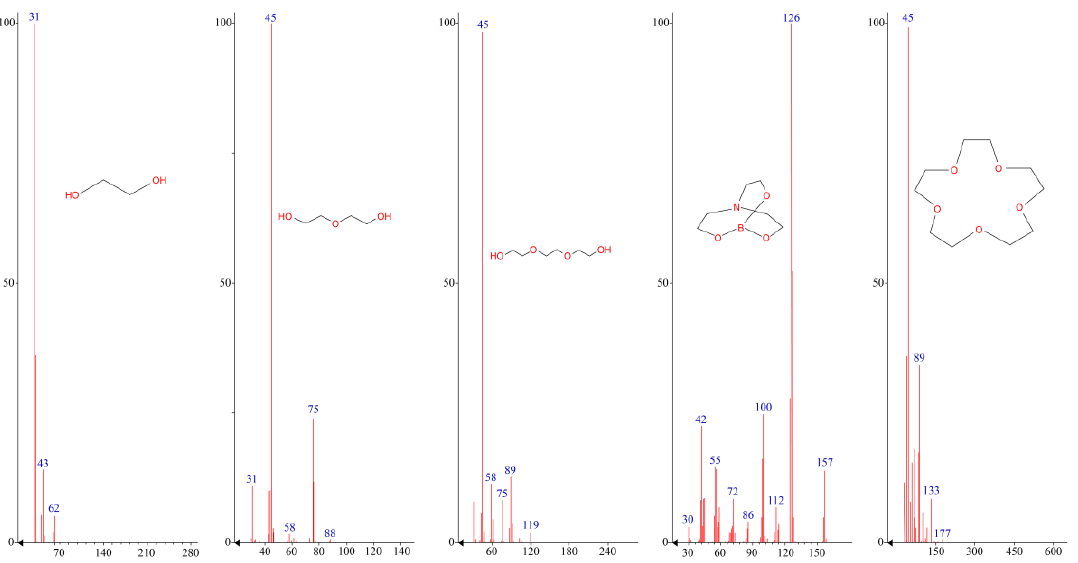
Figure 3. Mass-spectra of thermo-oxidative degradation products of AEBA.